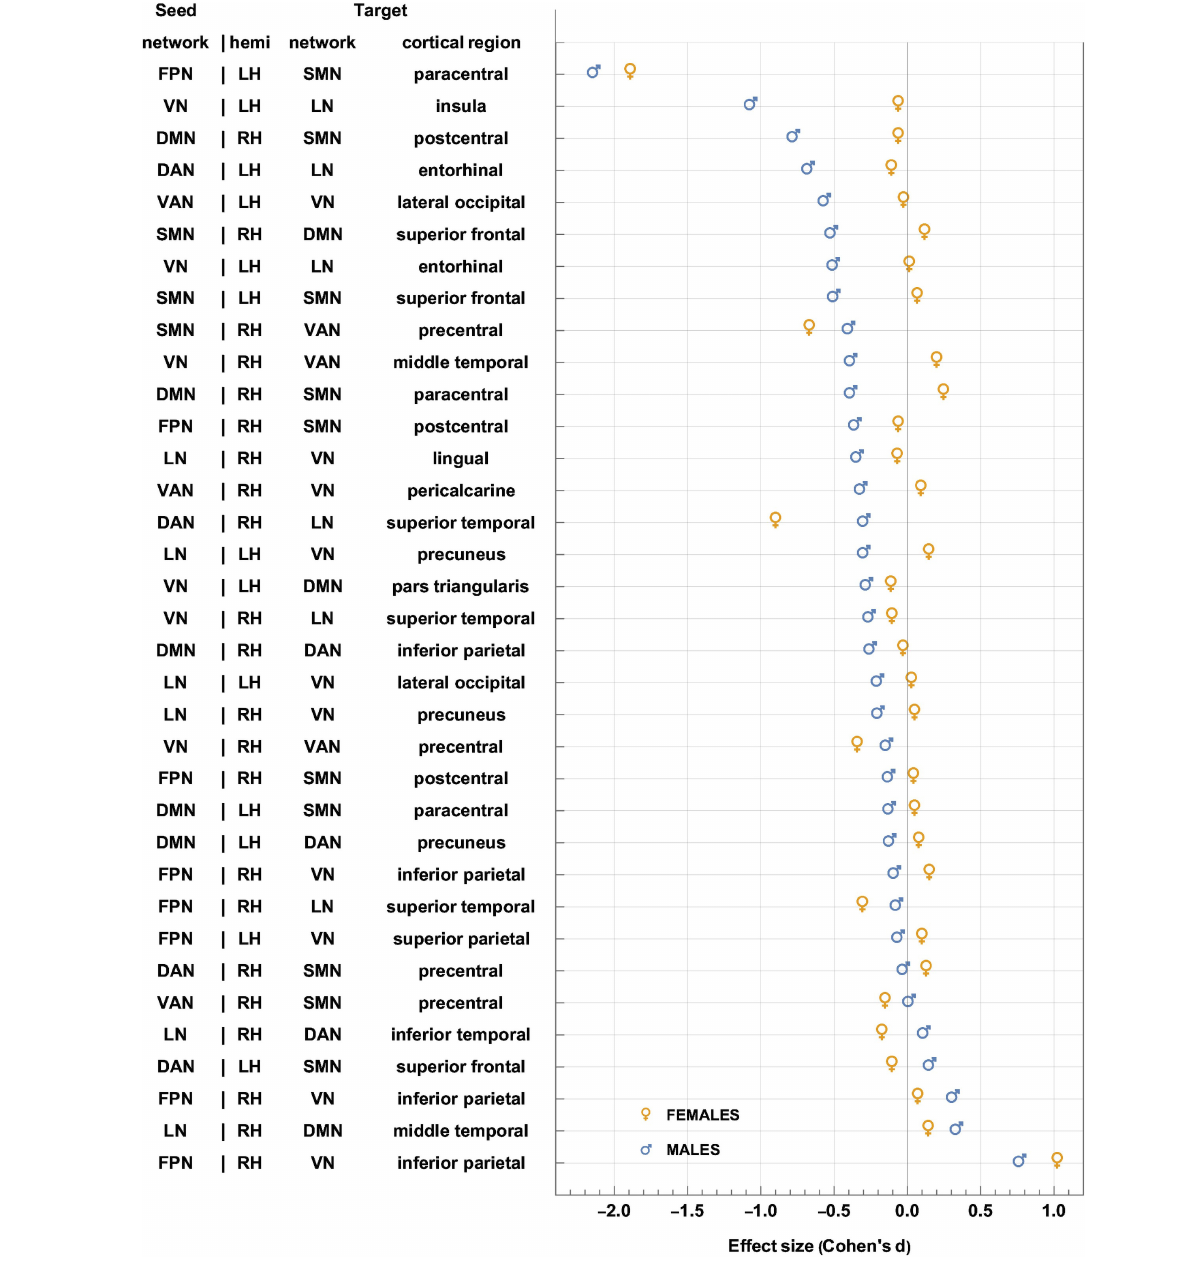
FIGURE 5 | Like Figure 4 , for sex-related effects. Clusters are sorted in ascending order of FC change in males. Females and males are indicated by gold blue symbols, respectively. Most significant findings are associated with greater FC decreases in males, whereas females’ typical significant FC changes are relatively smaller. FC, functional ♂